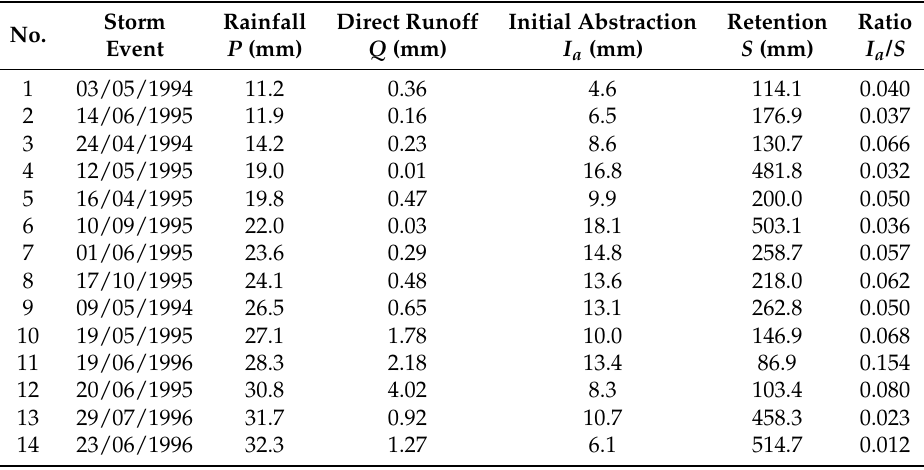
Figure 1. Location of study area in Wangjiaqiao watershed, China [13]. Table 1. Rainfall-runoff data of Wangjiaqiao watershed